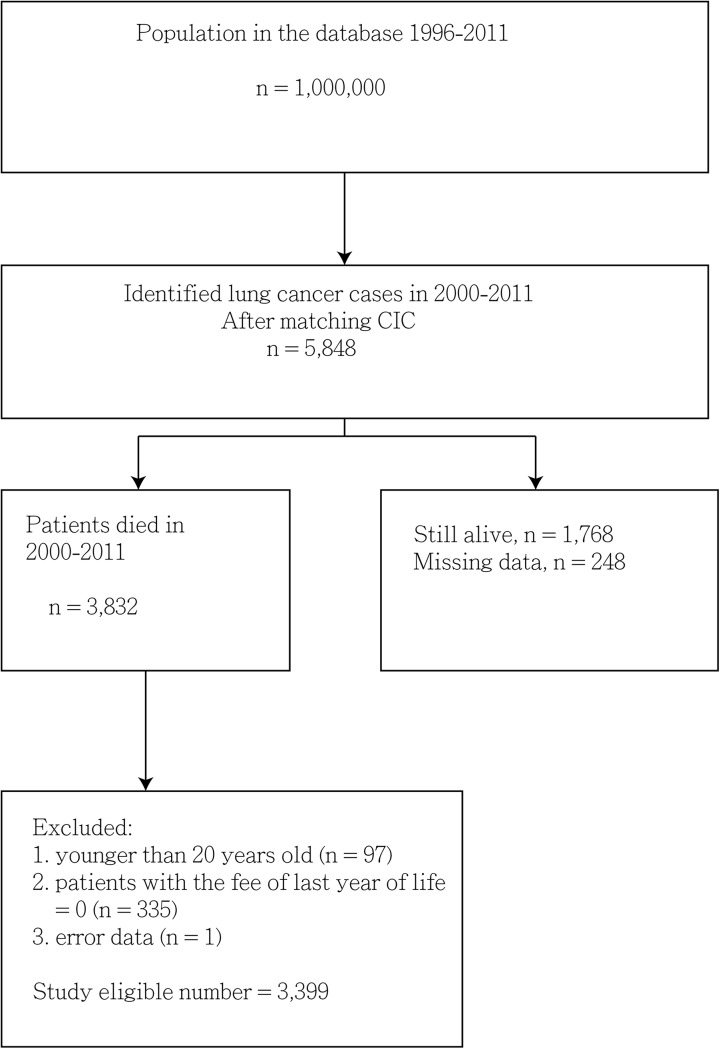
Study flow chart.Abbreviations: ICD-9-CM, International Classification of Diseases, Ninth Revision, Clinical Modification; CIC, catastrophic illness certificate.